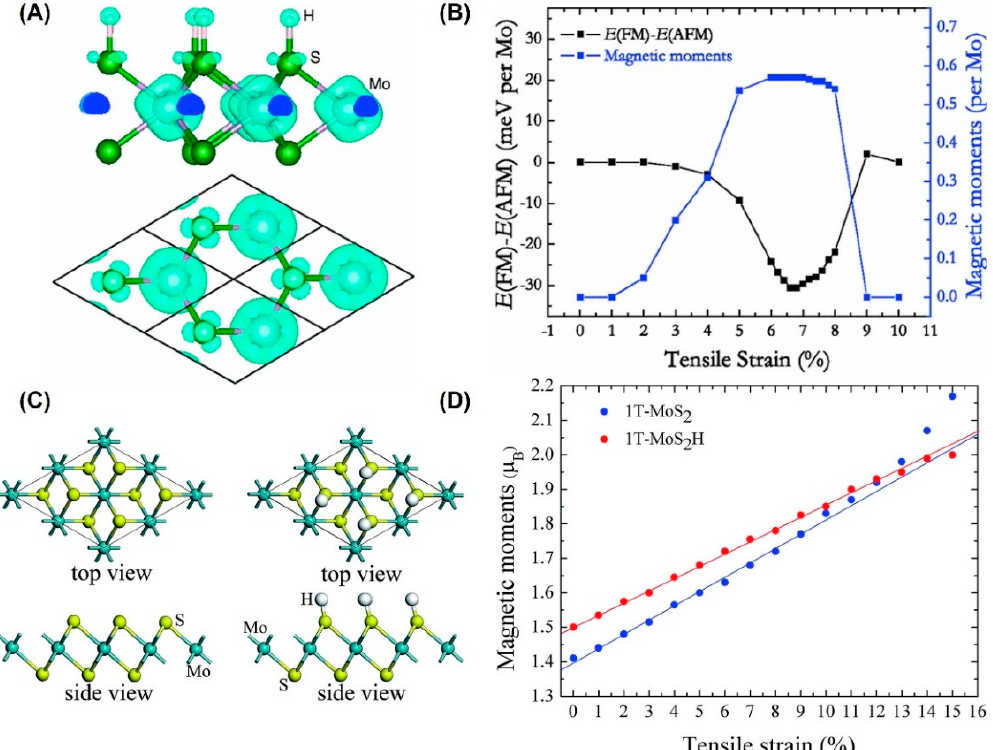
Figure 3. Strain-dependent magnetism in hydrogenated monolayer MoS 2 . ( A ) Contour plots of the spin density of hydrogenated monolayer 2H-MoS 2 under the biaxial tensile strain of 6%. (Reprinted/adapted with permission from Ref. [53]. Copyright 2013, American Physical Society). ( B ) Energy difference per Mo atom for 2H-MoS 2 H and the magnetic moment of Mo d orbitals per Mo as a function of strain (Reprinted/adapted with permission from Ref. [53]. Copyright 2013, American